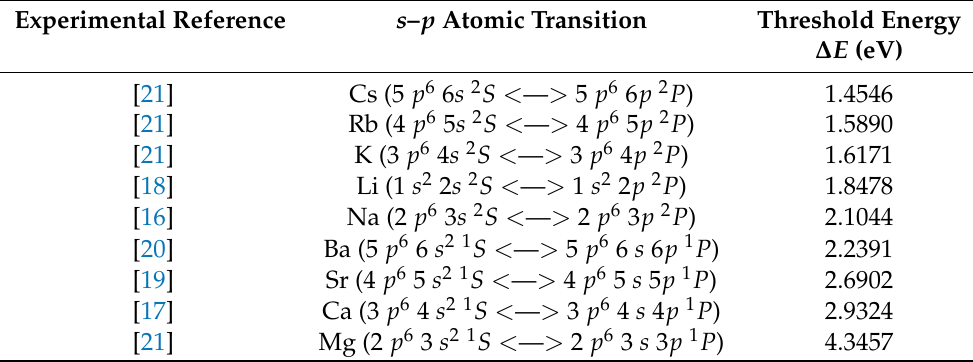
Table 1. s – p excitations of nine simple atoms. Values of ∆ E are available in the NIST database. Experimental